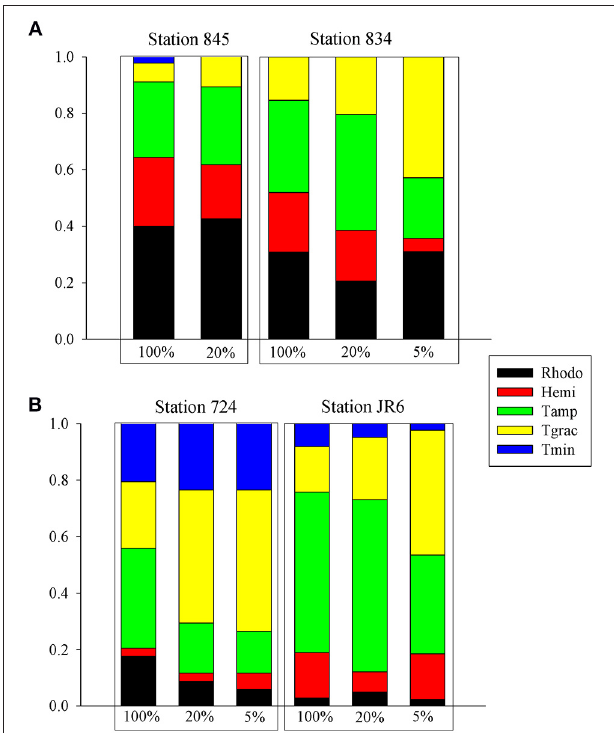
FIGURE 2 | Genetic diversity of cryptophytes in dilution experiments during October 2011 in Chesapeake Bay. Dilution experiment treatment is shown on the x-axis, % clone library composition on the y-axis. (A) Results for Stations 845 and 834; (B) Results for stations 724 and James River station 6. Rhodo: Rhodomonas sp., Hemi: Hemiselmis sp., Tamp: Teleaulax amphioxeia ; Tgrac: T. gracilis ; Tmin: T. minuta